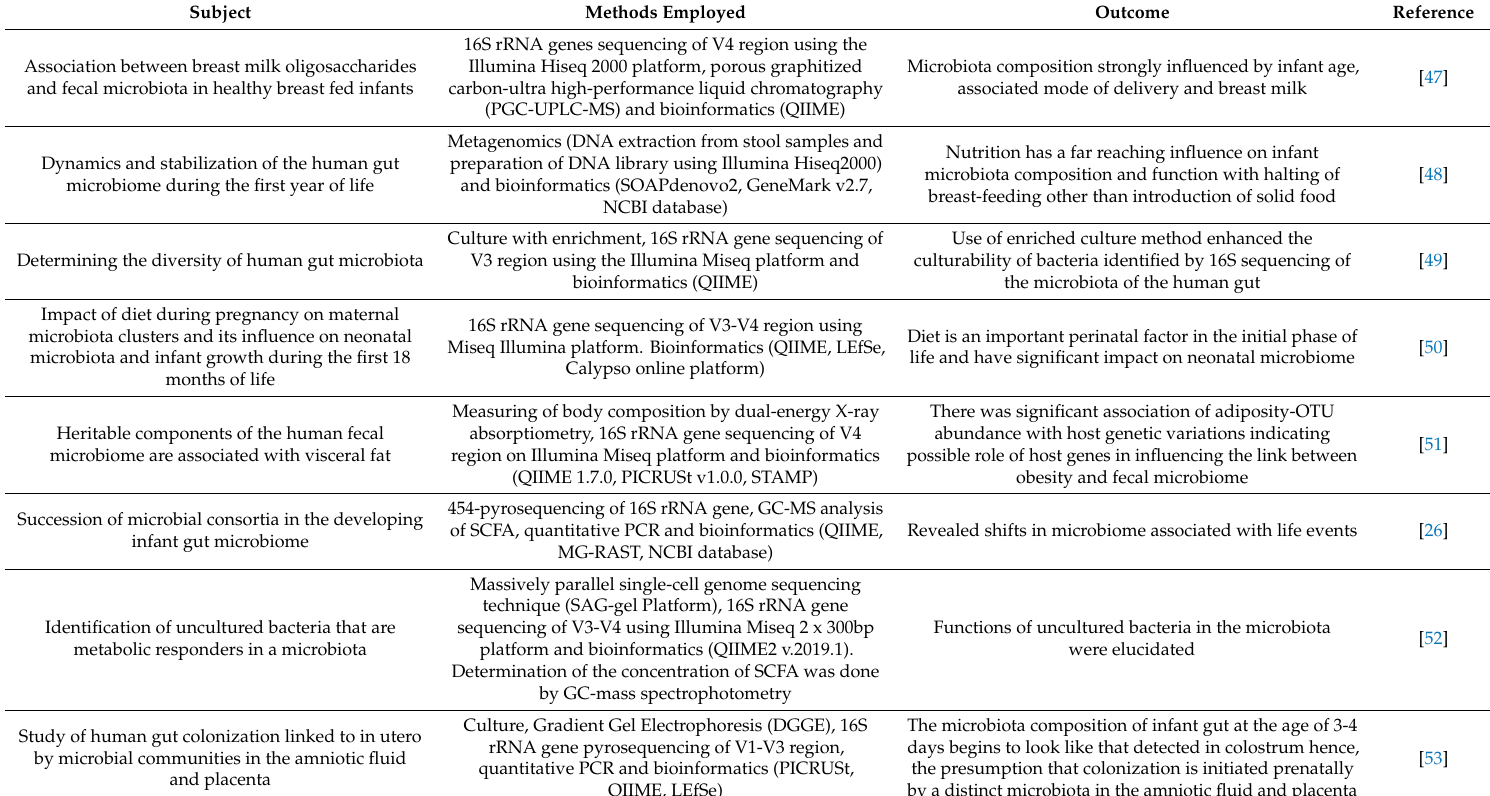
Table 2. Studies on Microbiome, Outcomes and Methods